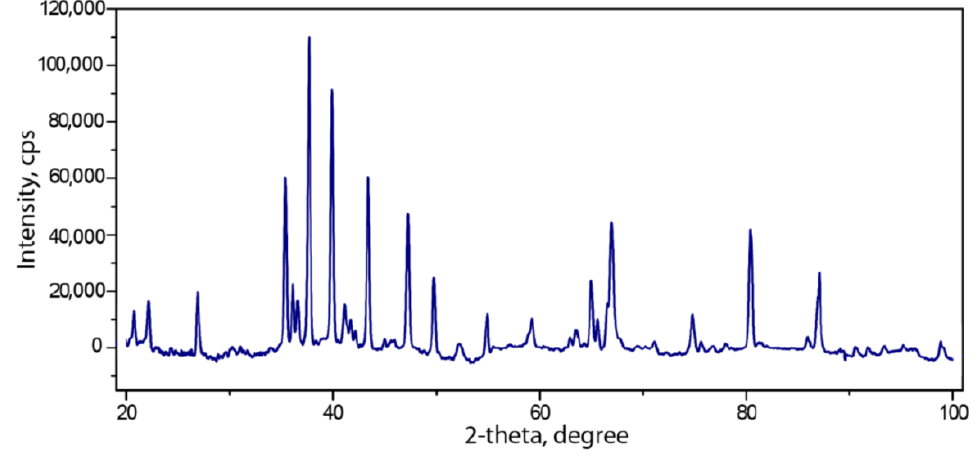
Figure 3. Powder diffraction spectra of barioferrite.